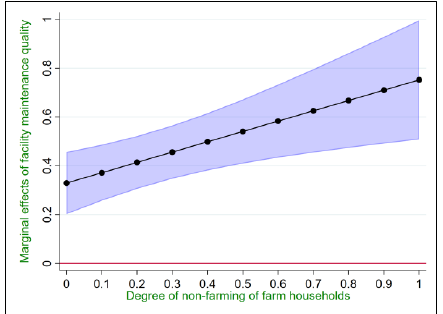
Figure 6. Moderating effect of the degree of non-farming of farm households on the adoption behavior of water-saving technologies. (Note: The black dashed line in the figure represents the moderating effect of the degree of farm household de-farming on the adoption behavior of farmers’ water-saving technologies influenced by property rights reform. The blue area represents the 95% confidence interval. The red line in the figure represents the significance level.).